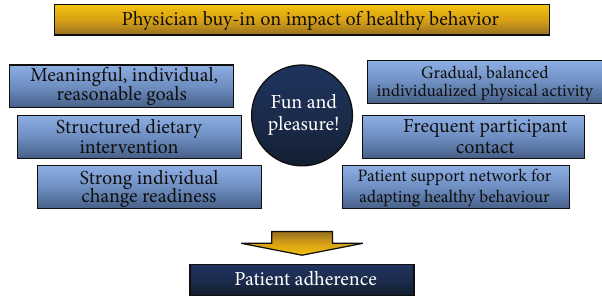
Figure 3: Drivers of adherence for the Canadian